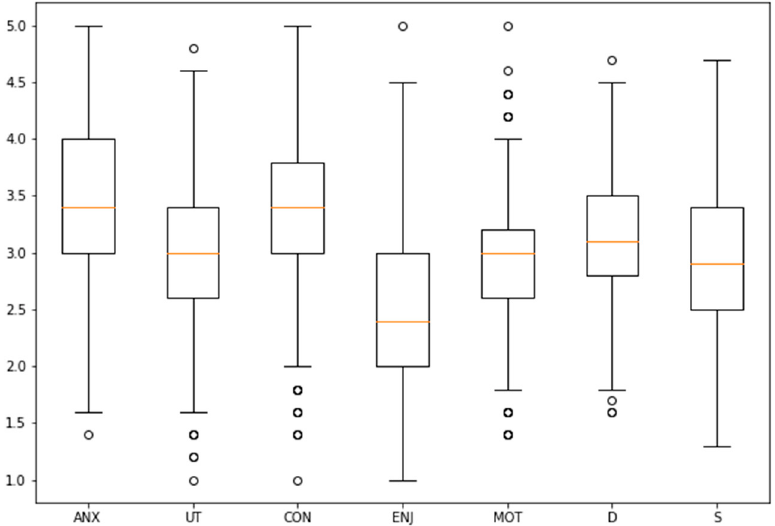
Figure 2. Distribution of students’ dimensions. MSATS: UT = Usefulness ( α = 0.81), ANX = Anxiety (reverse coded, α = 0.76); CON = Self-confidence ( α = 0.725), ENJ = Enjoyment ( α = 0.748); MOT = Motivation (reverse coded, ( α = 0.702) and R-SPQ-2F: D = Deep approach ( α = 0.715), S = Surface approach ( α = 0.723).